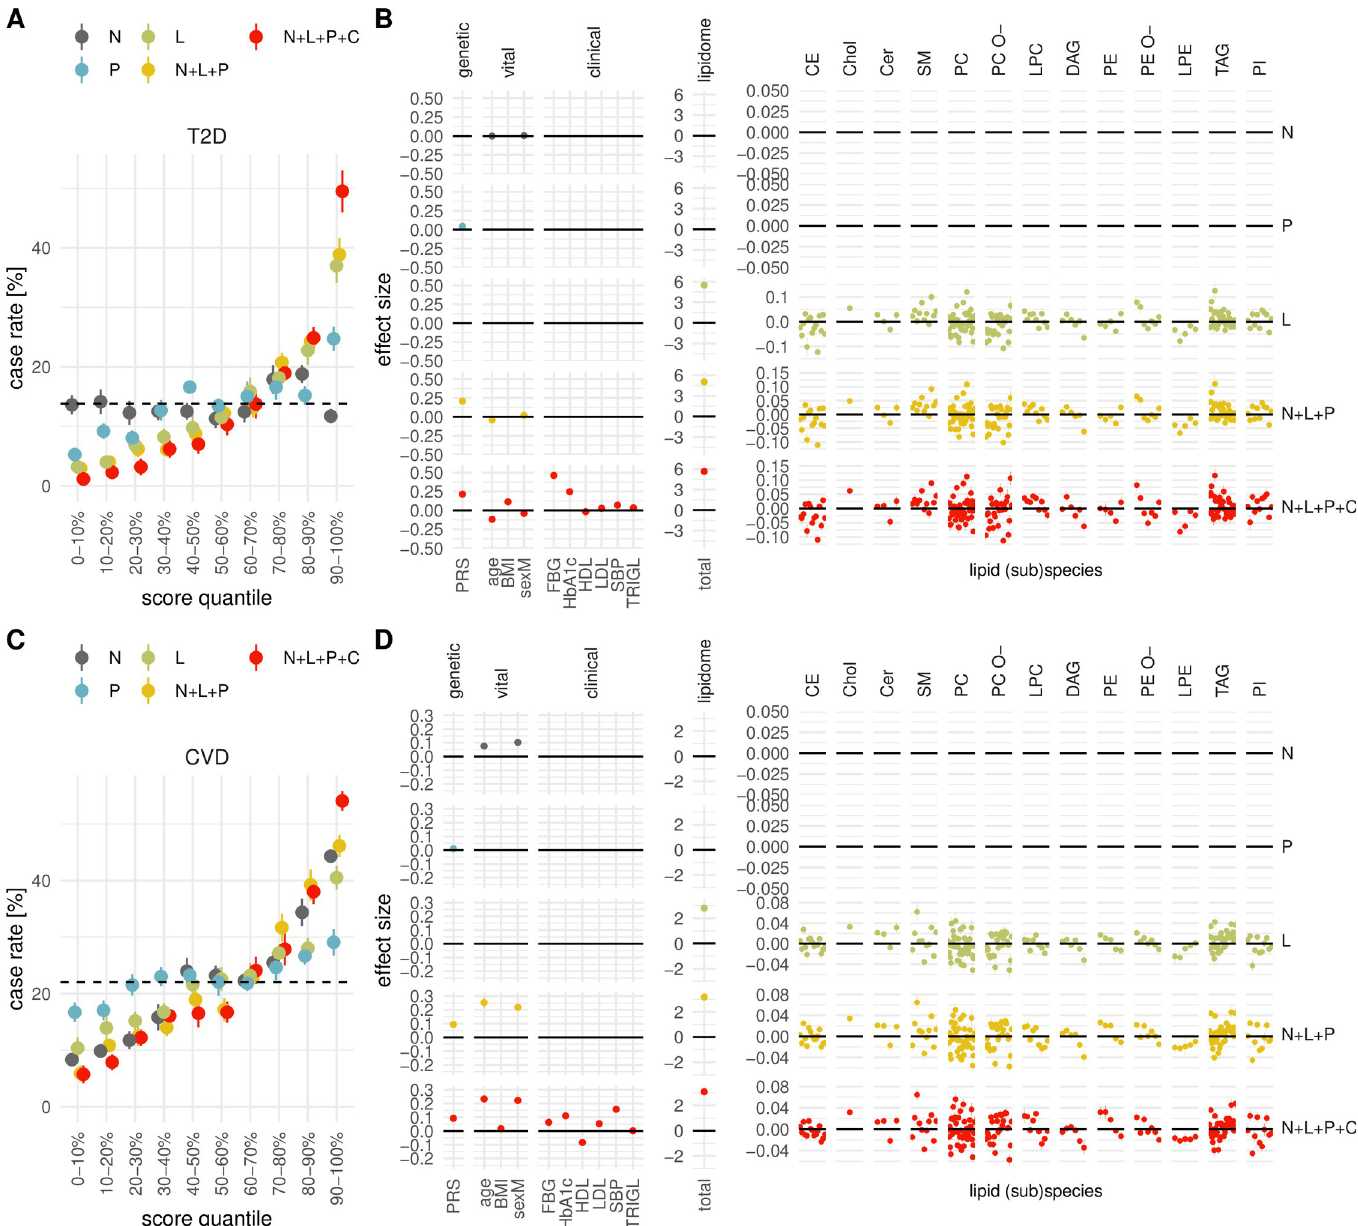
Fig 1. Correlation of different risk scores with future disease incidence rate. Different risk scores are sorted and partitioned into deciles; for each decile, the fraction of future T2D ( A ) and CVD ( C ) incidences is shown, with points indicating the mean over 10 independent repetitions and the bars the associated standard errors of the mean. The risk scores differ with respect to the included predictor variables: null model (N), lipidome (L), polygenic score (P), 7 standard clinical or vital measures (C). Different predictor types may be combined to derive composite scores like N + L + P comprising the null model, lipidome and polygenic predictors. The horizontal dashed line shows the average incidence rate across the full cohort. The effect sizes of individual predictor variables from each model are shown for T2D ( B ) and CVD ( D ) grouped by lipid class or predictor type. The data underlying this figure may be found in S1 Data. BMI, body mass index, sum of absolute effect sizes across all lipid species/subspecies (total); CE, cholesteryl ester; Cer, ceramide; Chol, cholesterol; CVD, cardiovascular disease; DAG, diacylglyceride; FBG, fasting blood glucose; HbA1c, glycated hemoglobin; HDL, high-density lipoprotein; LDL, low-density lipoprotein; LPC, lysophosphatidylcholine; LPE, lysophosphatidylethanolamine; PC, phosphatidylcholine; PC O-, ether- phosphatidylcholine; PE, phosphatidylethanolamine; PE O-, ether- phosphatidylethanolamine; PI, phosphatidylinositol; PRS, polygenic risk score; SBP, systolic blood pressure; SM, sphingomyelin; TAG, triacylglyceride; TRIGL, triglyceride; T2D, type 2 diabetes.